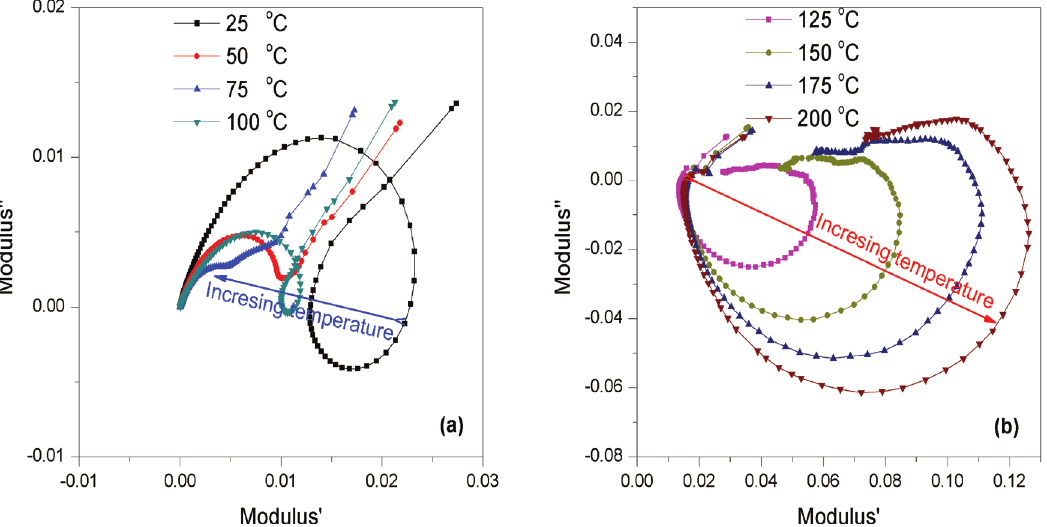
Fig. 3: Cole-Cole plot of the Electrical Modulus; a) down, b) up from 100 °C of the